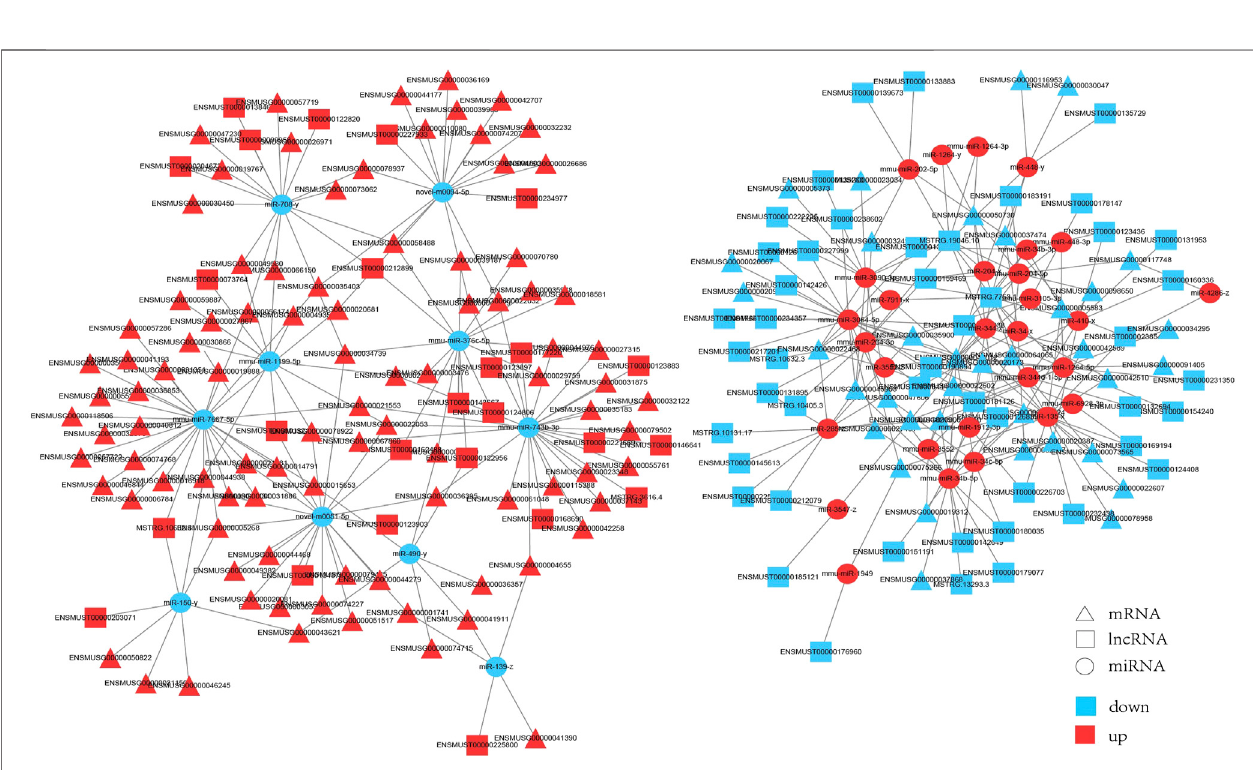
Frontiers in Genetics |